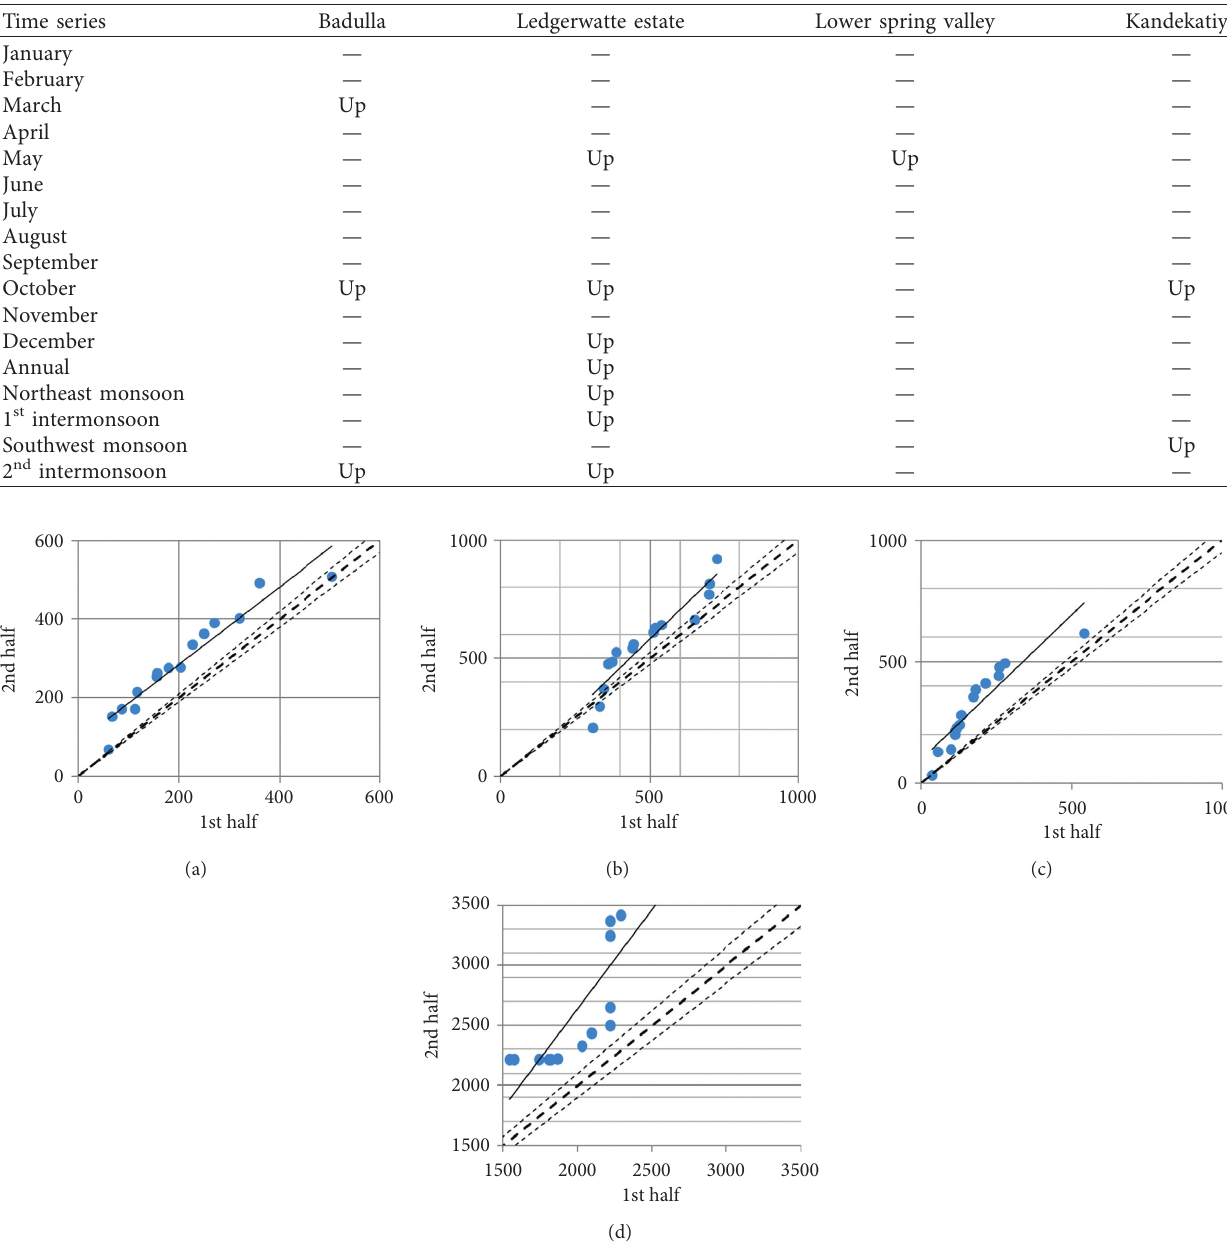
Table 2: Results from innovative trend analysis.